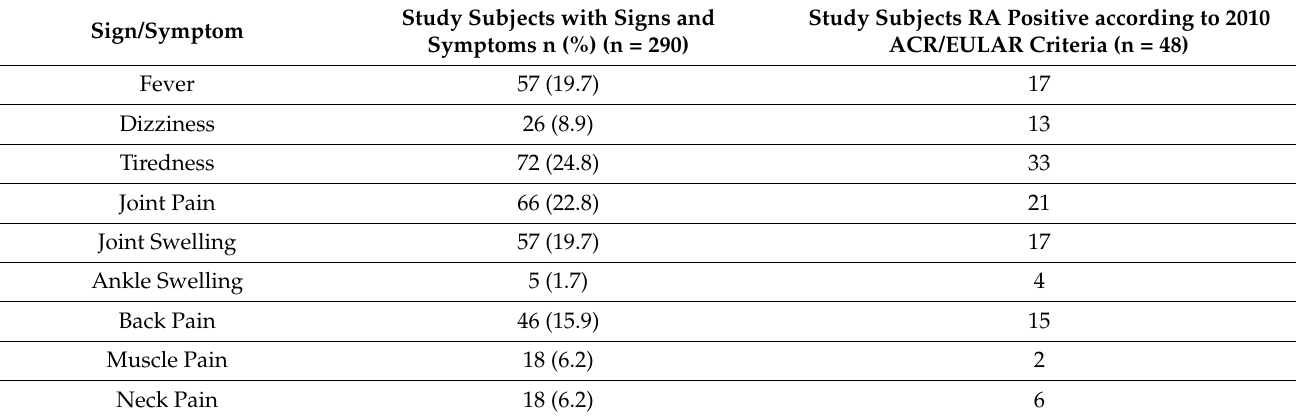
Table 1. Distribution of signs and symptoms profile of the study